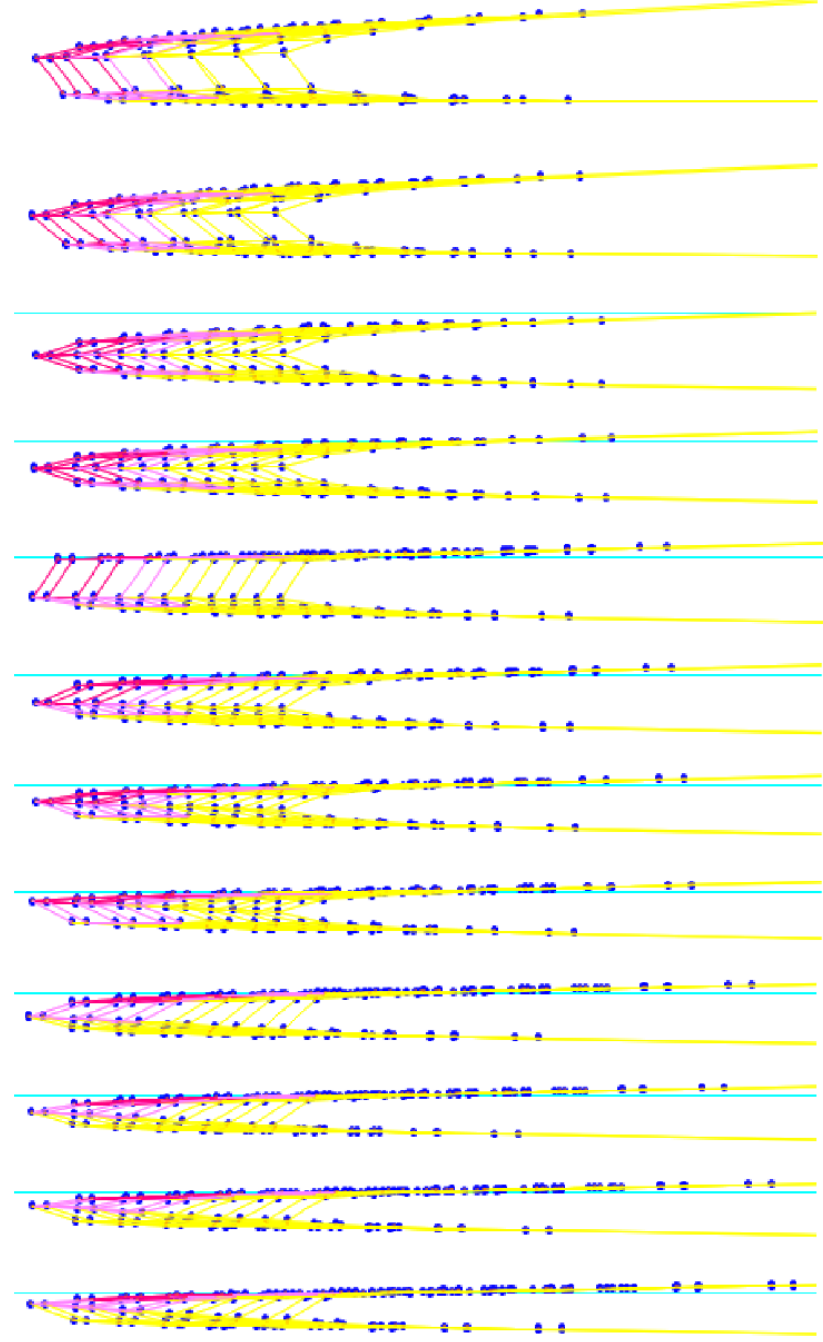
Figure 36. Shape changes of the flexible trawl in straight-line towing at v = 5 m/s.